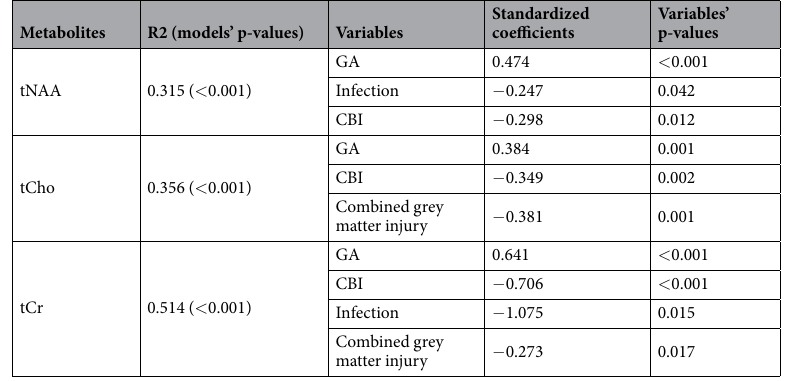
Table 3. Best forward multiple linear regression models of clinical complications associated with cerebellar metabolites 1 . Legend: 1 in mM/kg; GA, gestational age at MRI; CBI, cerebellar